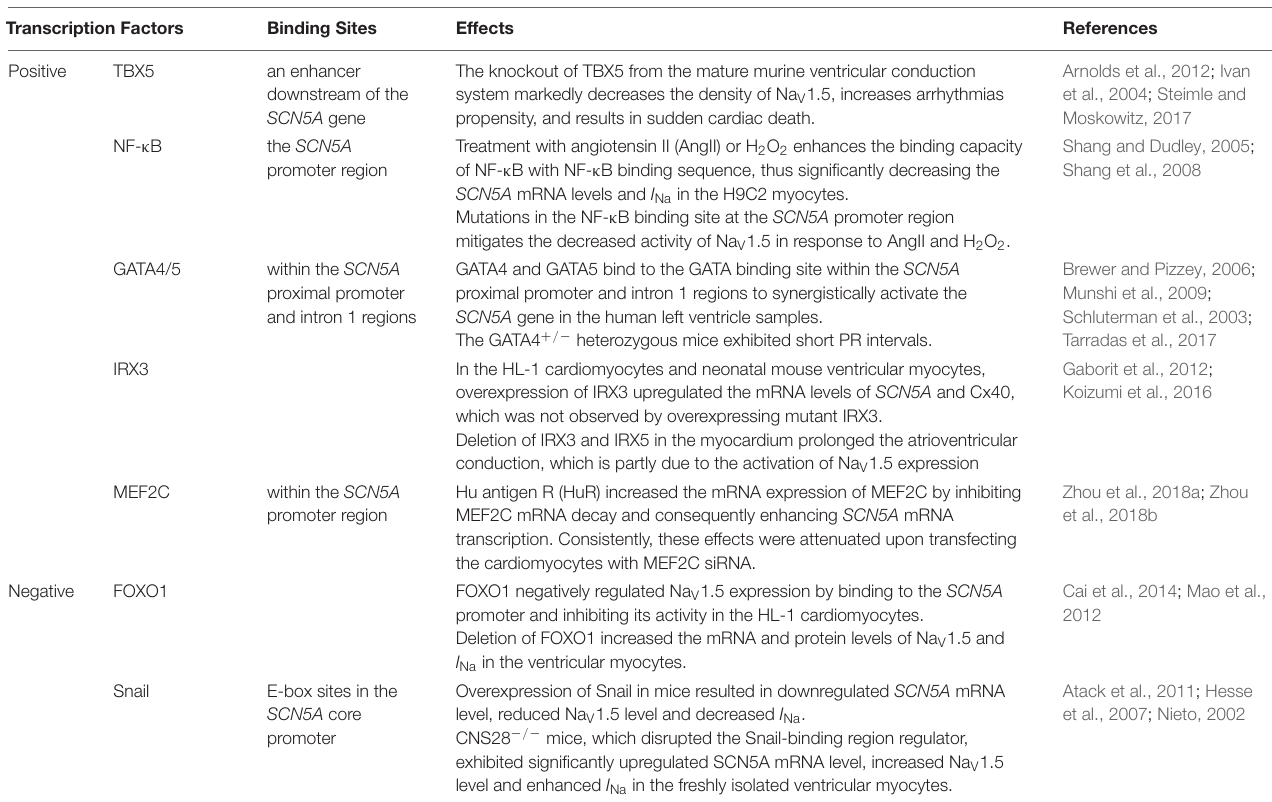
TABLE 1 | Transcription factors of Na V 1.5 and their binding